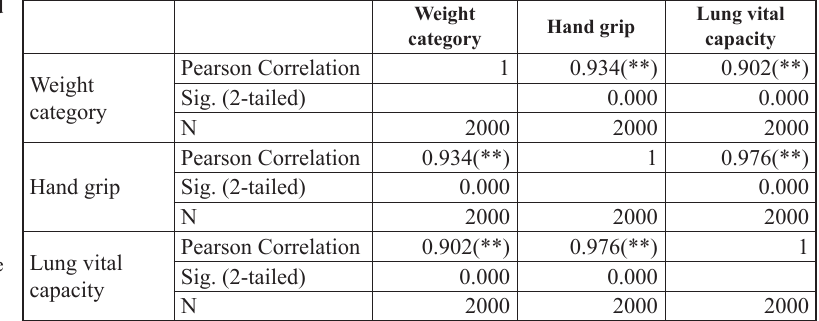
Table 4. Correlations of weight, hand grip strength and lung vital capacity